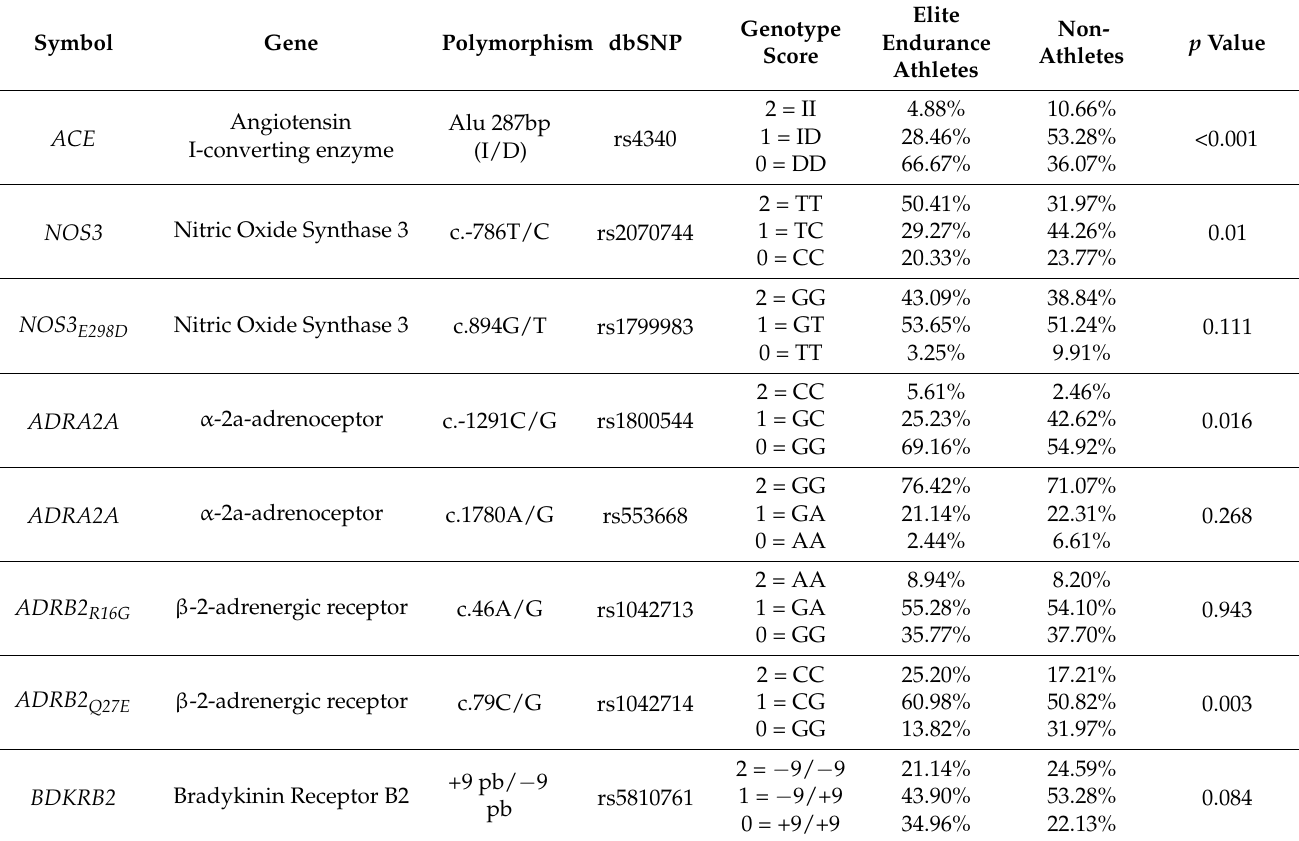
Table 1. Studied polymorphisms in elite endurance athletes and